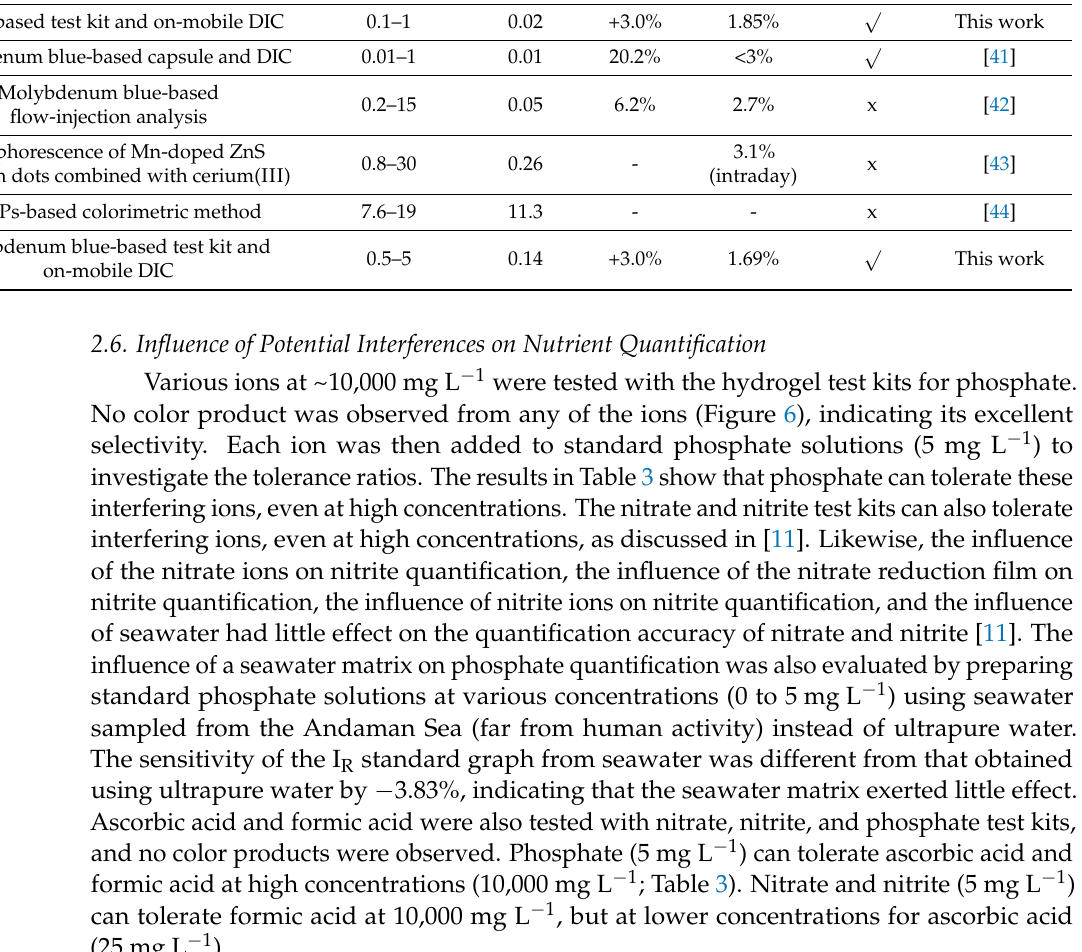
Table 3. Concentrations of various species that caused changes in the I R of the blue products